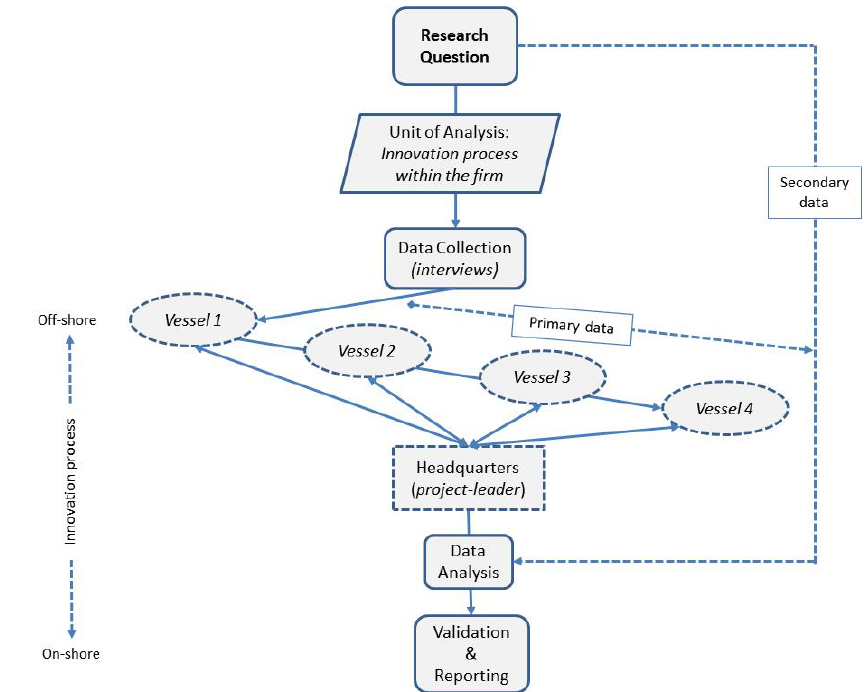
Fig. 2 . Research design (adapted based on Gjosaeter & Kyvik,